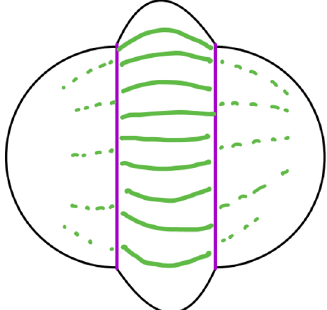
Figure 11 . In the bilayer proposal a horizon is composed of two layers which can independently source bit-threads. The area density of bit-threads on each layer is bounded by 1 / 4 G .